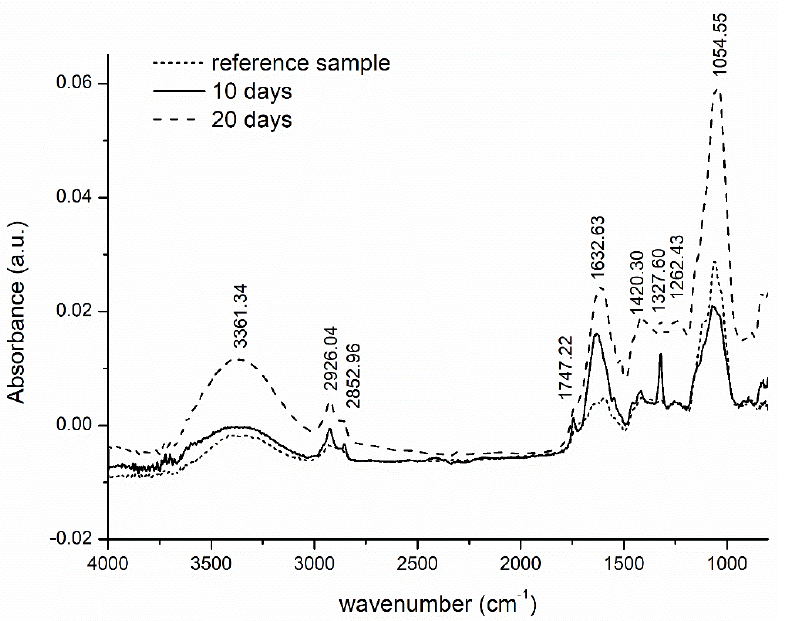
Figure 13. ATR-FTIR spectra for reference sample H15CA, and hydrogel sample after 10 days and 20 days in soil, respectively .